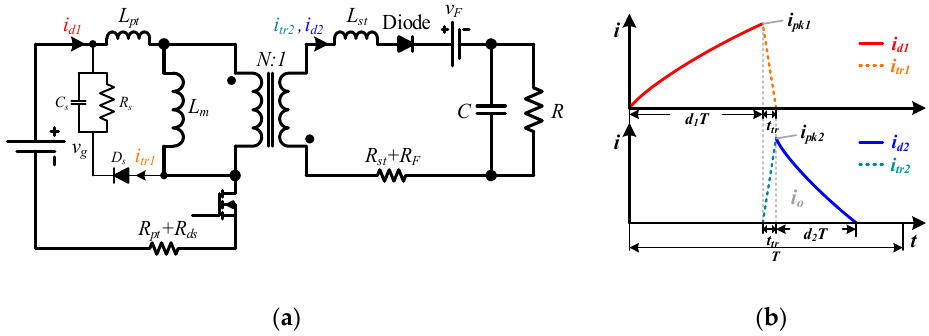
Figure 6. Flyback converter with consideration of parasitics, leakage inductance of transformer and RCD snubber circuit. ( a ) Circuit scheme, ( b ) Currents of primary and secondary windings.